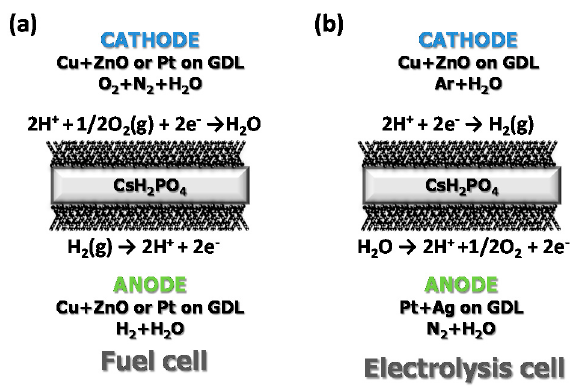
Figure 1. Fuel cell ( a ) and electrolysis cell ( b ) configuration.